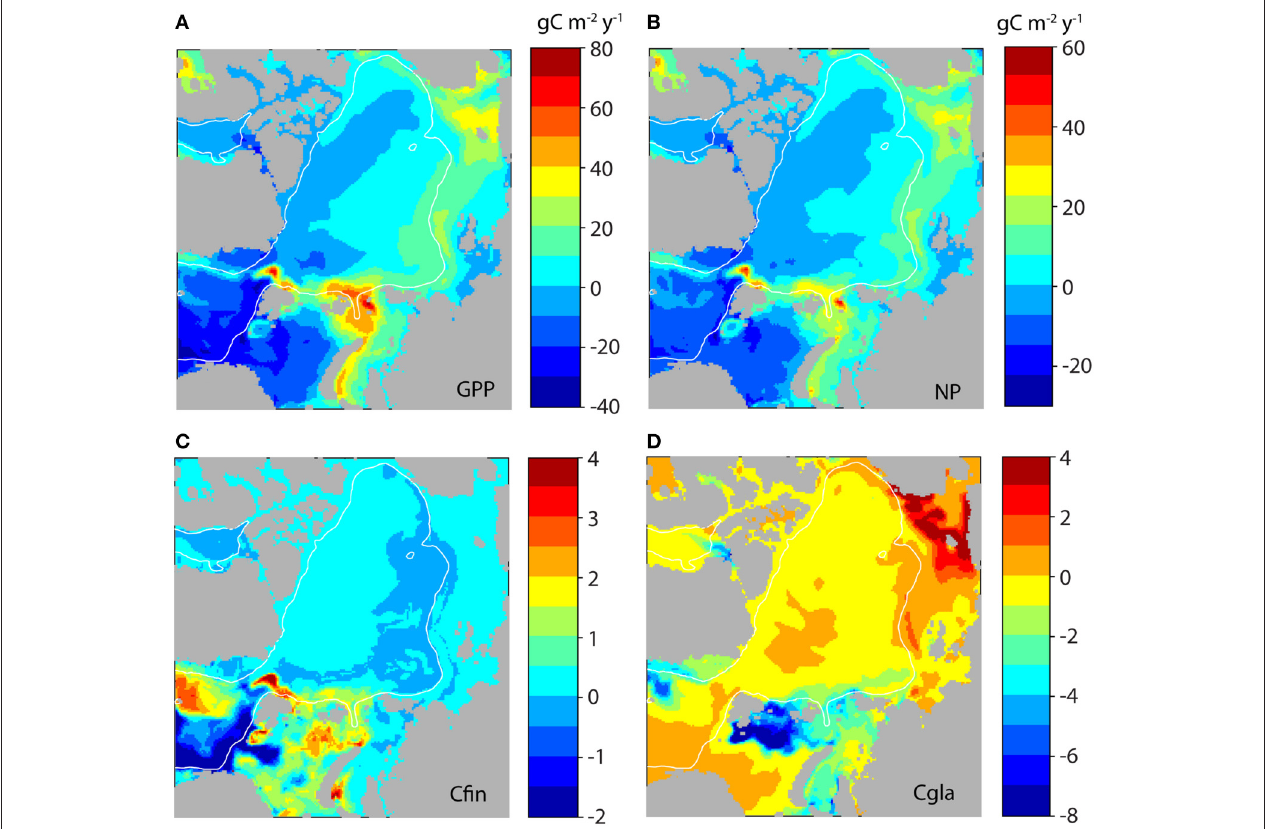
FIGURE 12 | Difference between the simulated gross primary production (GPP, A) and new production (NP, B) between 2099 and 2010 (as based upon Figure 8; g C m − 2 y − 1 ). Also shown is the difference between simulated production of Calanus finmarchicus (Cfin, C ) and C. glacialis (Cgla, D